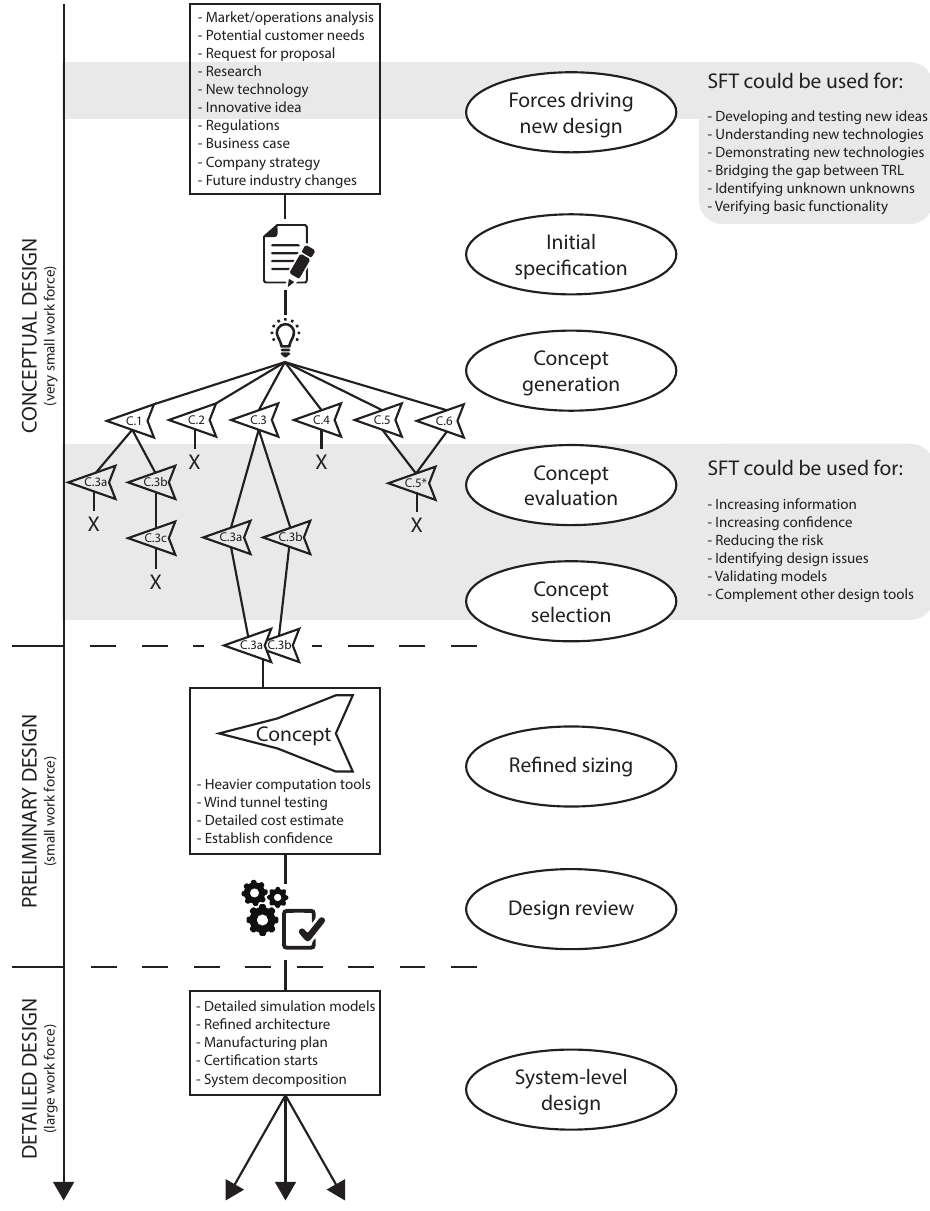
Figure 15. An interpretation of the initial stages of a contemporary aircraft development process, where the shaded areas indicate the potential application of